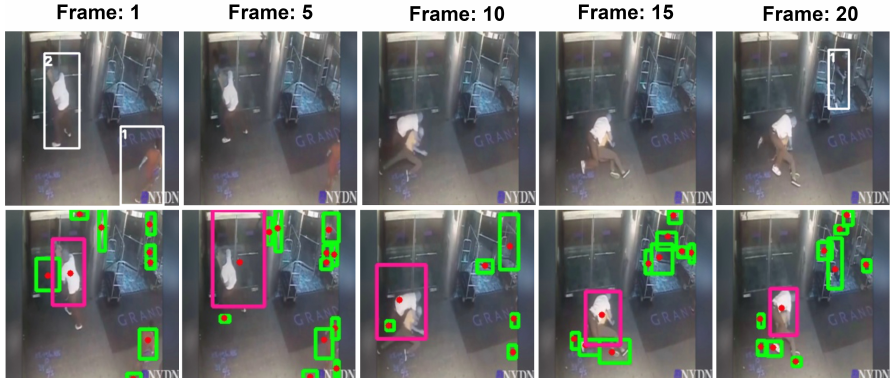
Figure 10. A sequence of frames of a violent video from the RWF-2000 dataset with person detections (white boxes) and final motion regions (pink boxes). The person detector fails in most frames (first row), which produces an action tube that cannot be extracted. In this case, we use the motion regions (second row) to build the action tube.